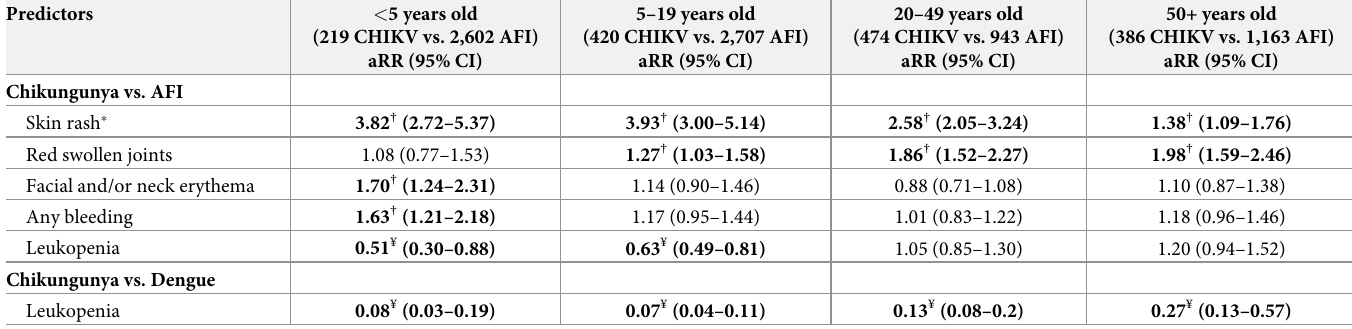
Table 3. Age group-specific predictors of laboratory-confirmed chikungunya versus all other acute febrile illnesses or laboratory-confirmed dengue regardless of the timing of presentation, Acute Febrile Illness Study, May 7, 2012–May 6, 2015, Puerto Rico.